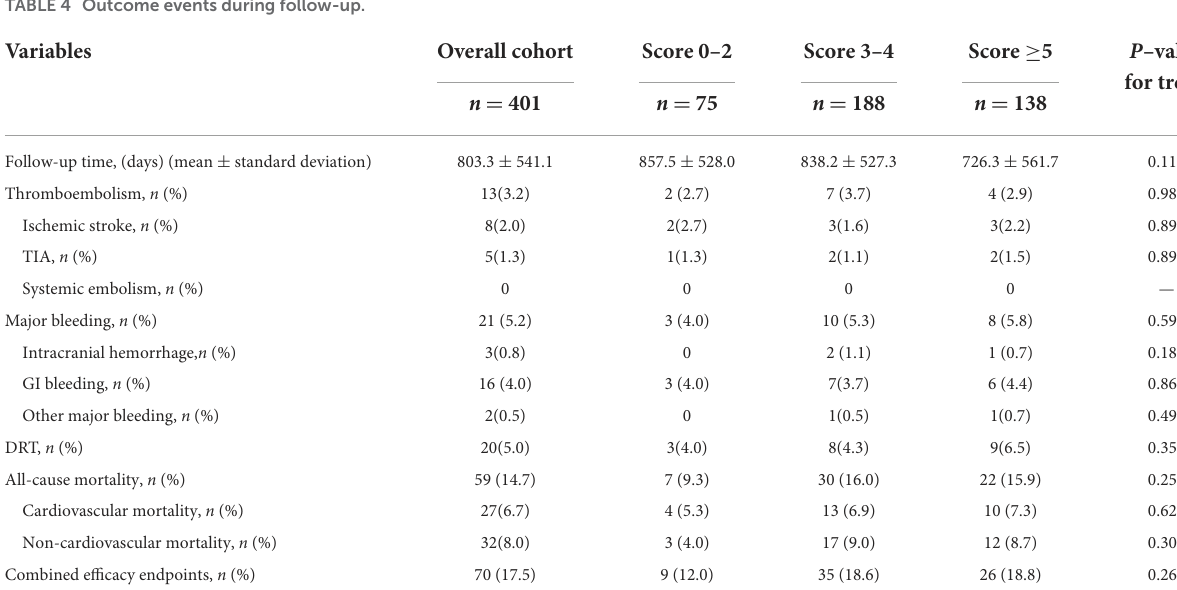
TABLE 4 Outcome events during